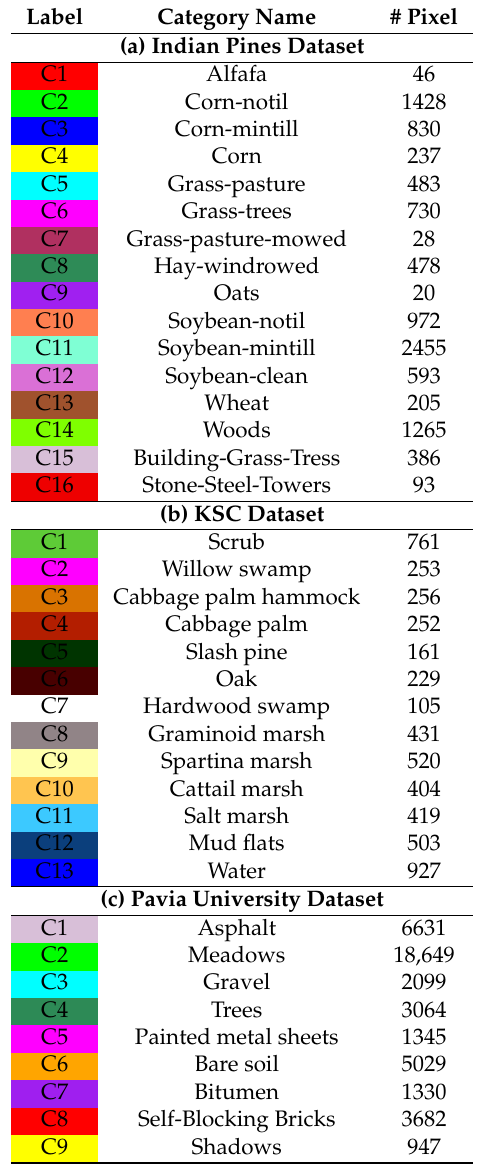
Table 1. Detailed categories and number of instances of Indian Pines dataset (The colours represent the colour labels that are used in the figures of Section